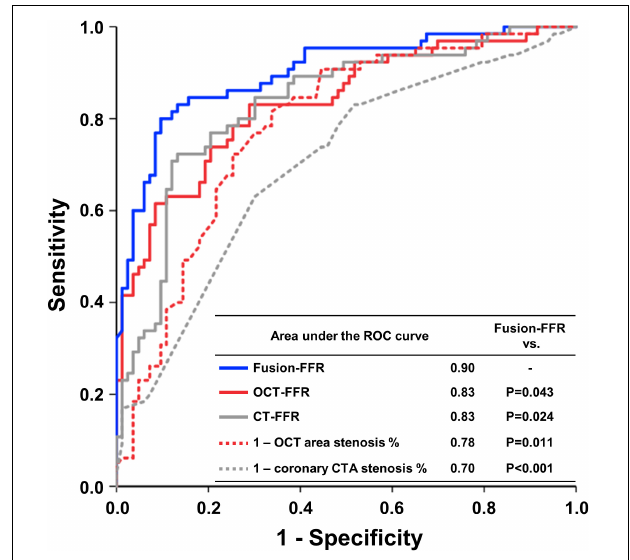
FIGURE 4 | Receiver operating characteristics curves in assessing functionally significant stenosis for CFD-based computational FFRs and anatomic variables. Receiver operating characteristics (ROC) curves with area under the curve to assess functionally significant stenosis for Fusion-FFR, OCT-FFR, CT-FFR, percentage area stenosis on OCT, and percentage coronary CTA stenosis. CFD, computational fluid dynamics; CTA, computed tomography angiography; CT-FFR, computational FFR from coronary CTA; FFR, fractional flow reserve; Fusion-FFR, computational FFR from coronary CTA-OCT fusion images; OCT, optical coherence tomography; OCT-FFR, computational FFR from